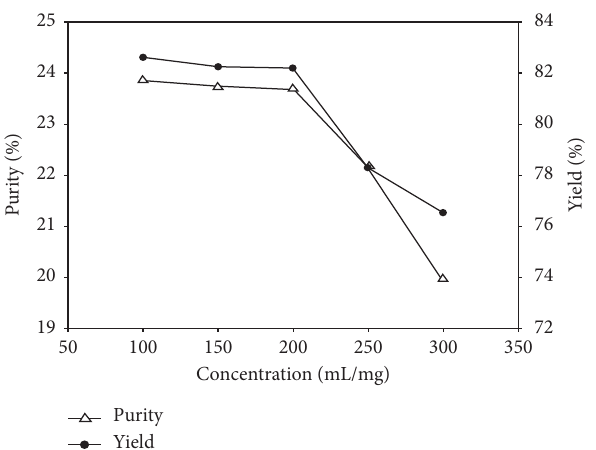
Figure 2: The effect of feed concentration on the purification of BKBA.